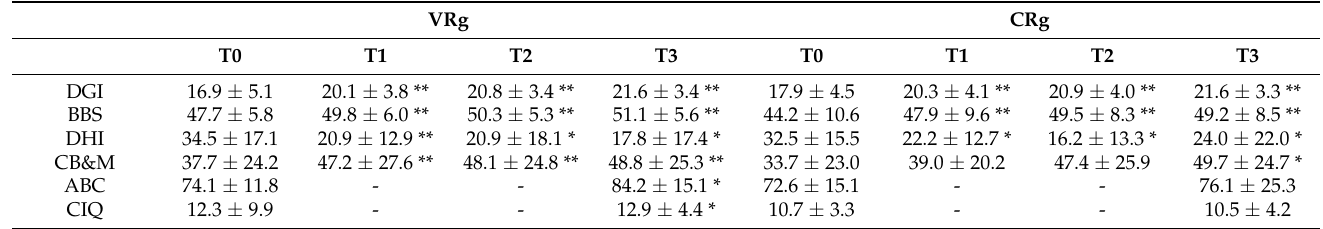
Table 2. Clinical Scale Scores. Mean ± SD; VRg = vestibular rehabilitation group; CRg = conventional rehabilitation group; ABC Scale = Activities-Specific Balance Confidence Scale; BBS=Berg Balance Scale; CB&M = Community Balance and Mobility Scale; CIQ = Community Integration Questionnaire; DGI = Dynamic Gait Index; DHI = Dizziness Handicap Inventory; the symbols * and ** indicate statistically significant differences with respect to T0 ( p < 0.05 and p < 0.001, respectively). VRg CRg T0